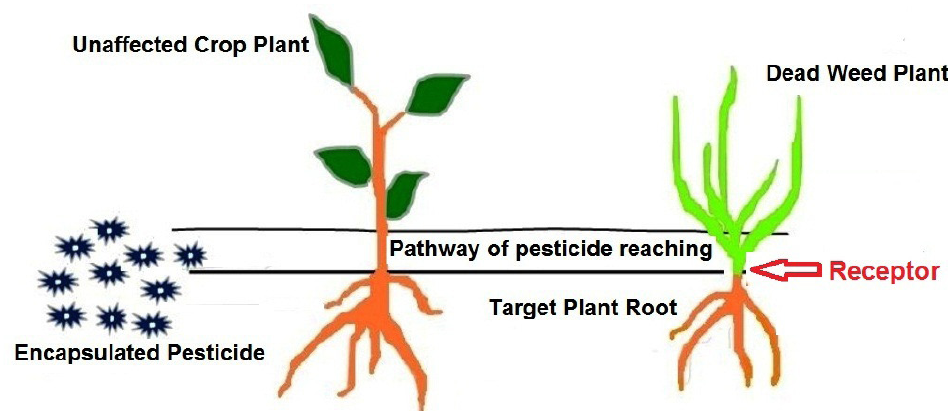
Figure 4. Targeted pesticide delivery to weed receptors.